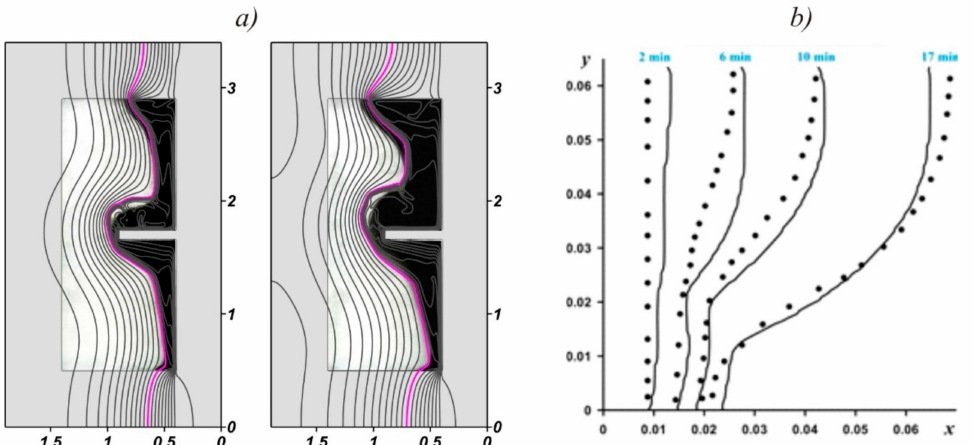
Figure 3. Validation of the developed mathematical model and numerical technique: comparison of calculated outcomes (solid lines) and experimental results (black and white photography) [44] ( a ); comparison of obtained numerical data (solid line) and experimental data (dots) [46] ( b ).